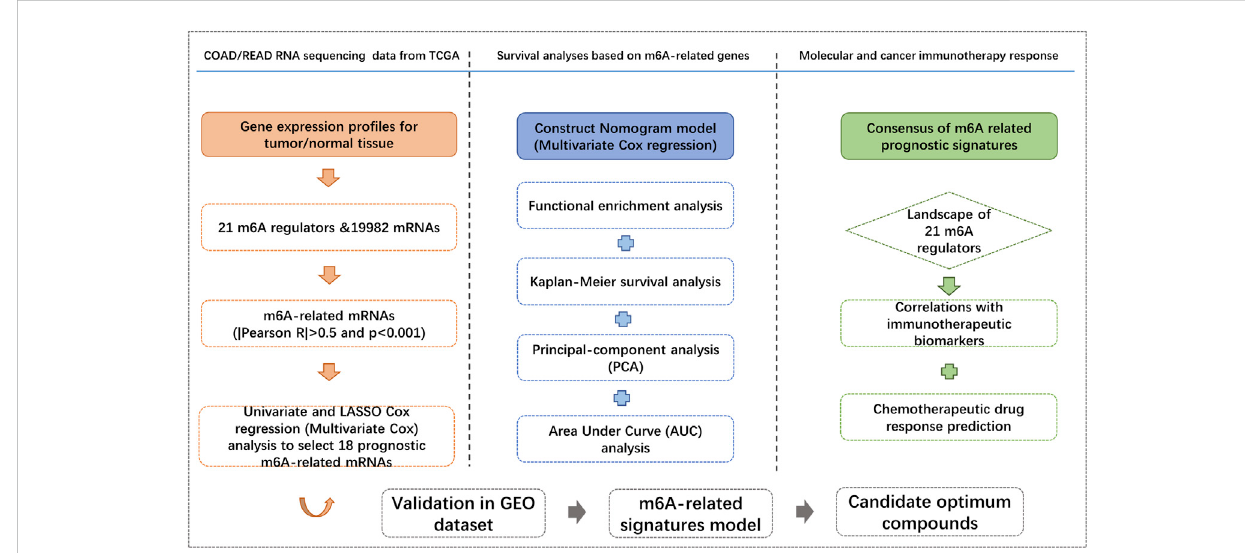
FIGURE 2 Flow chart of this